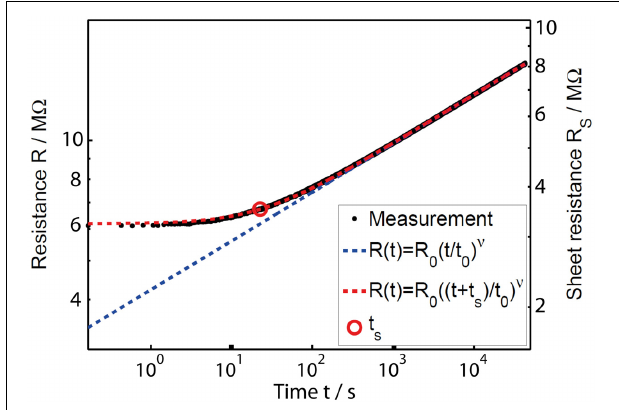
FIGURE 3 | Double logarithmic plot of the resistance drift in amorphous as-deposited GeTe upon annealing at (80.00 ± 0.03) ◦ C. The black raw data points for the resistance were measured via two contacts. A normalization of these data was done with the help of a four-point Van-der-Pauw measurement directly after the drift experiment (leading to the sheet resistance values indicated by the right vertical axis). The common power law (blue dashed line) matches the experimental results well for long annealing times only. An extended power law (red dashed line) taking into account the thermal history of a sample, however, can describe the resistance drift in amorphous as-deposited phase change films over the whole measurement range [17].